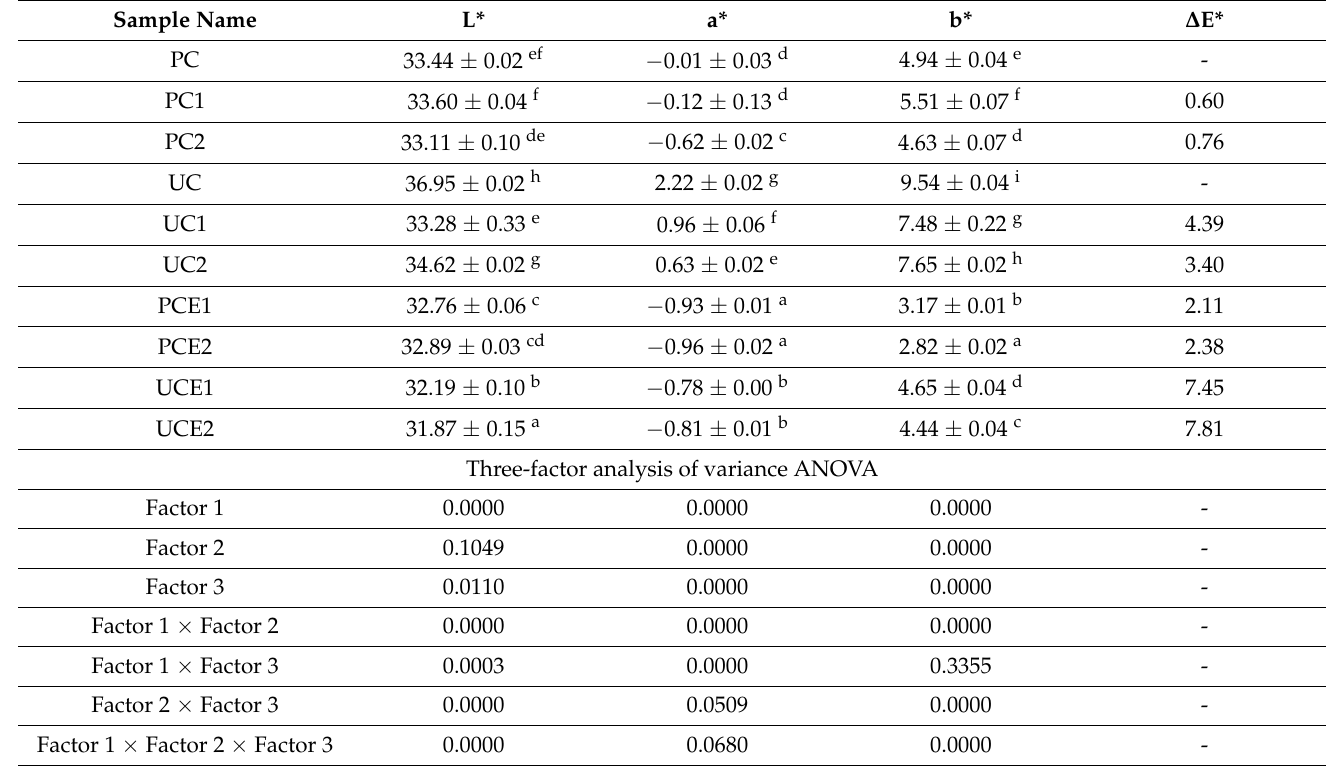
Table 5. Effect of pectinase on celeriac pulp on CIE L*a*b* color parameters and differences ( ∆ E*) in